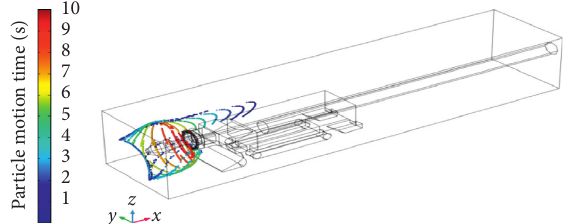
Figure 15: Particle trajectory with an air volume of 4m 3 /min.